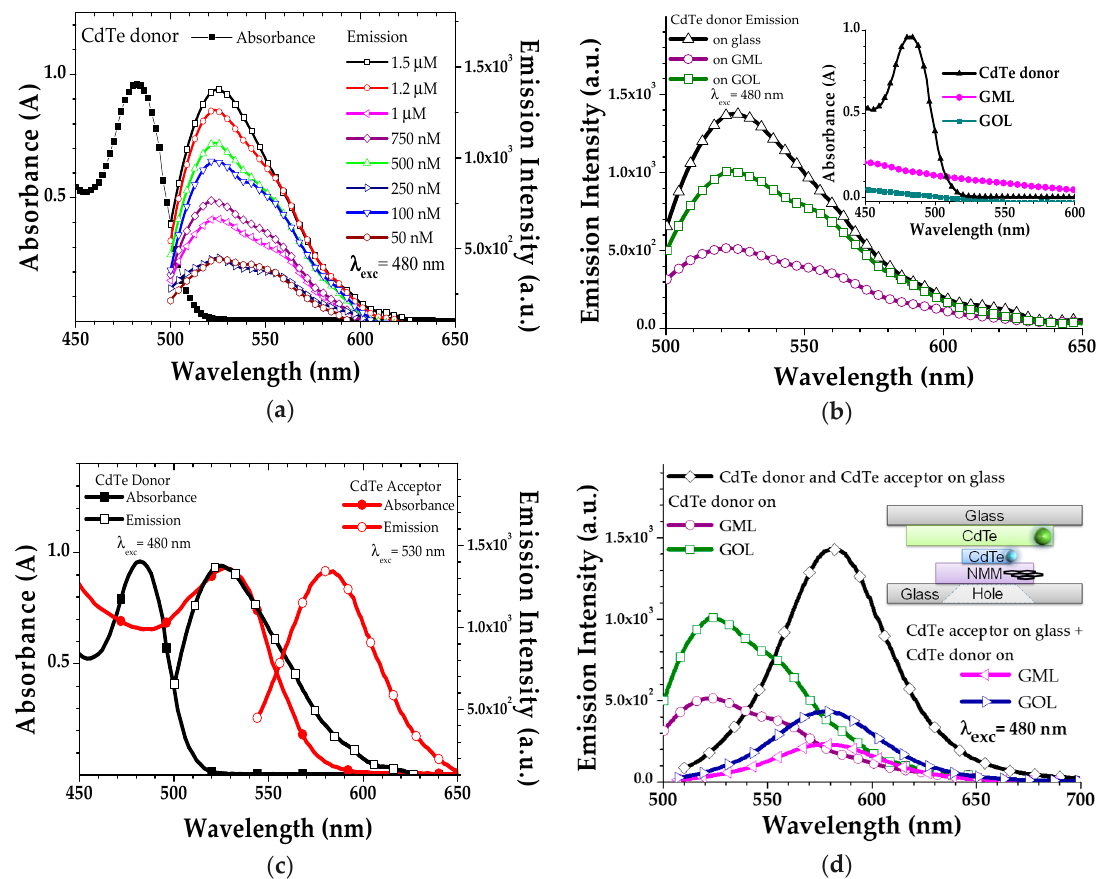
Figure 5. ( a ) Absorption and emission spectra of CdTe donor with the concentration dependent emission intensity characteristics on glass slides; ( b ) emission characteristics of (donor CdTe attached on GOL) and (donor CdTe attached on GML) under 480 nm excitation light. Inset figure corresponds to the self-absorption characteristics of the CdTe donor, GML and GOL; ( c ) absorption and emission spectra with the spectral overlap (shaded area) of CdTe donor and CdTe acceptor materials and ( d ) emission characteristics of the connected (donor CdTe attached on NMM + acceptor CdTe coated glass) devices with the comparison of (donor CdTe attached on NMM). Inset image shows the general (donor CdTe attached on NMM + acceptor CdTe coated glass) device structure where the CdTe donor attached on NMM is connected directly to CdTe acceptor coated glass. Emission intensities in a, b and d are collected for the λ exc = 480 nm.